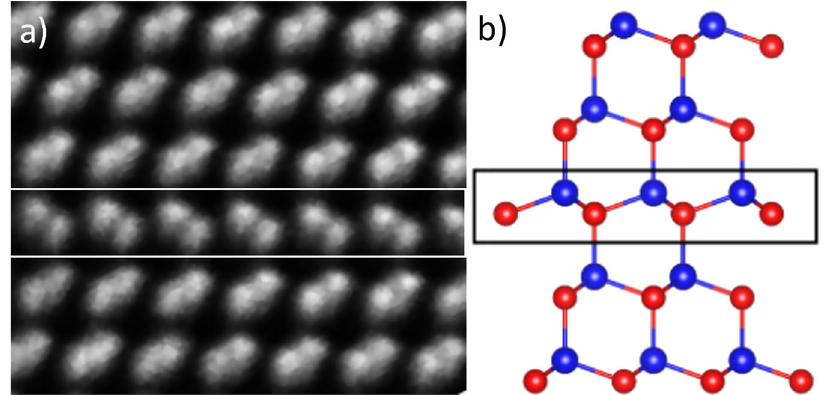
Fig. 4 Intrinsic tetrahedral stacking fault. a HRTEM image showing an Intrinsic Tetrahedral stacking fault 13 . b Schematic of this type of fault. Cd: Blue, Te: